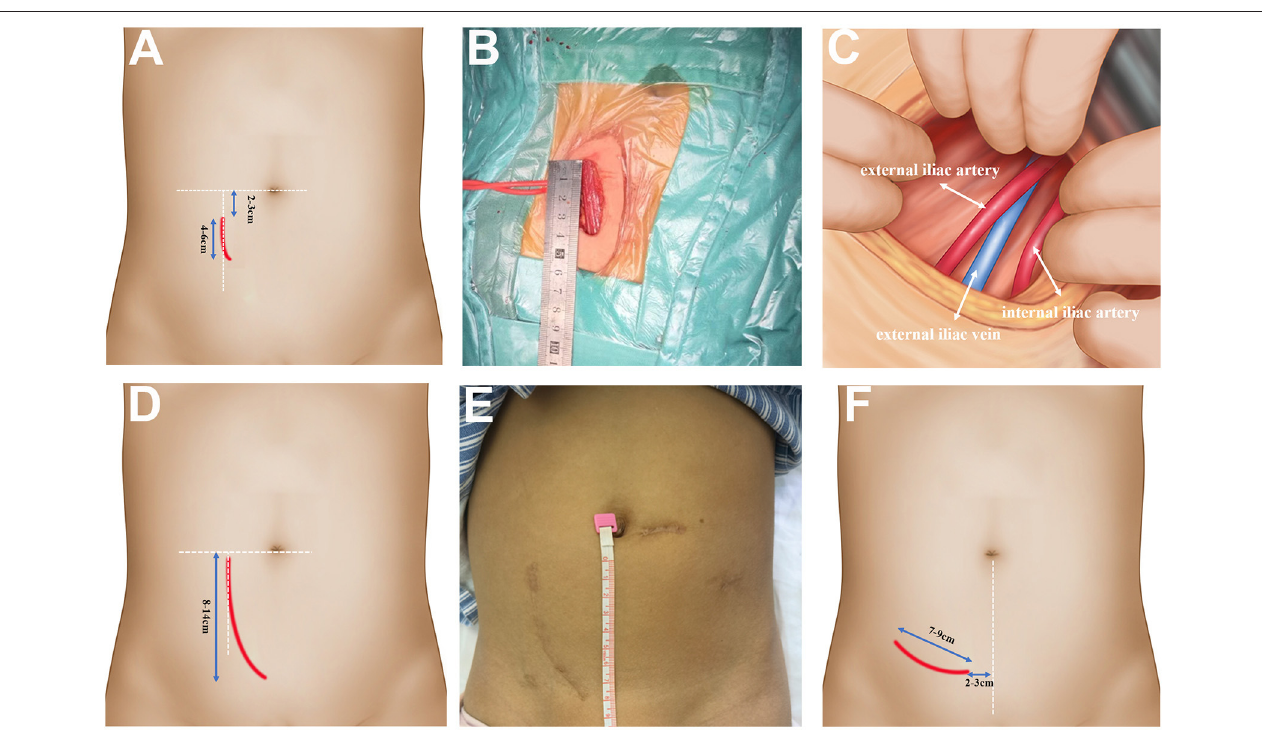
FIGURE 2 | The operative approach of SMIPKT and CKT. (A) The operative approach of SMIPKT. (B) A ∼ 4cm incision in SMIPKT in a 9-year-old patient. (C) The internal iliac artery and the external iliac vein were fully exposed and dissected free in a minimalistic fashion in SMIPKT. (D) The operative approach of CKT. (E) A ∼ 8.5cm incision in CKT (final result 2 years post-transplant in a 9-year-old patient). (F) The transverse incision of MIKT by Oyen and